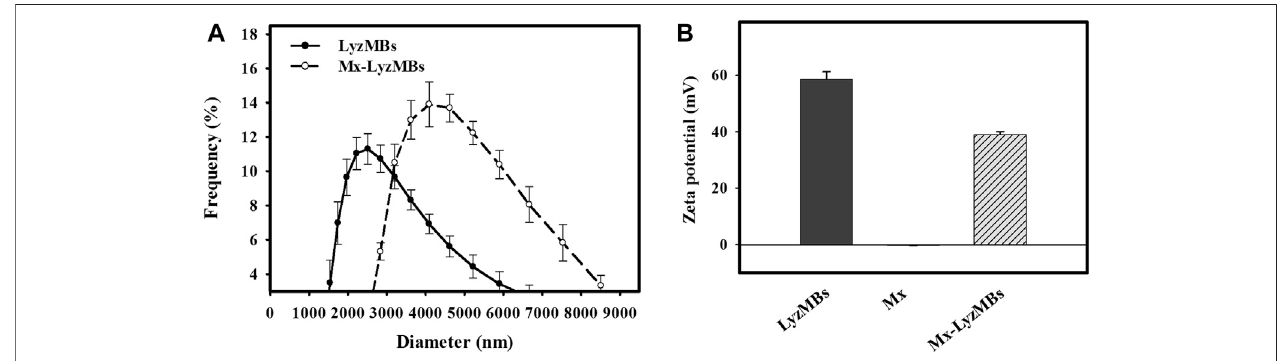
FIGURE 3 | Quanti fi cation of the size distributions (A) and zeta potentials (B) of LyzMBs, Mx, and Mx-LyzMBs. Data are mean and SEM values.